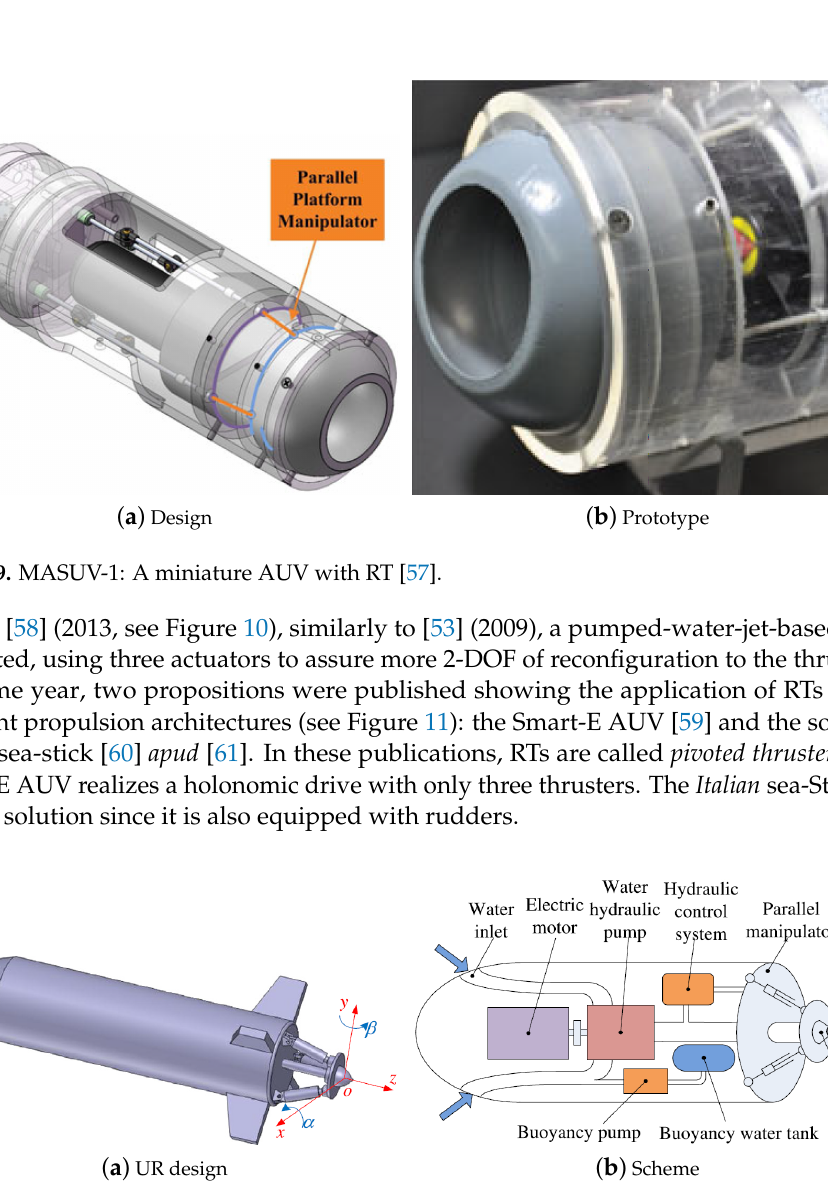
Figure 10. An AUV concept equipped with a pumped-water-jet-based RT [58].